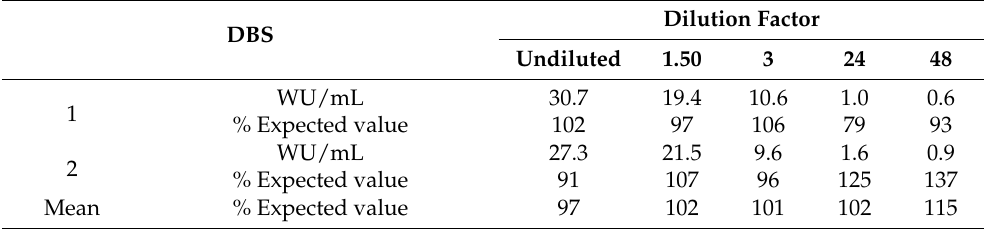
Table 1. Dilution linearity of DBS samples starting with 30 WU/mL HEV IgG analyzed in parallel (DBS 1 and 2). Results are presented in IgG level (WU/mL) and the difference between the observed and expected IgG level in percent (% expected